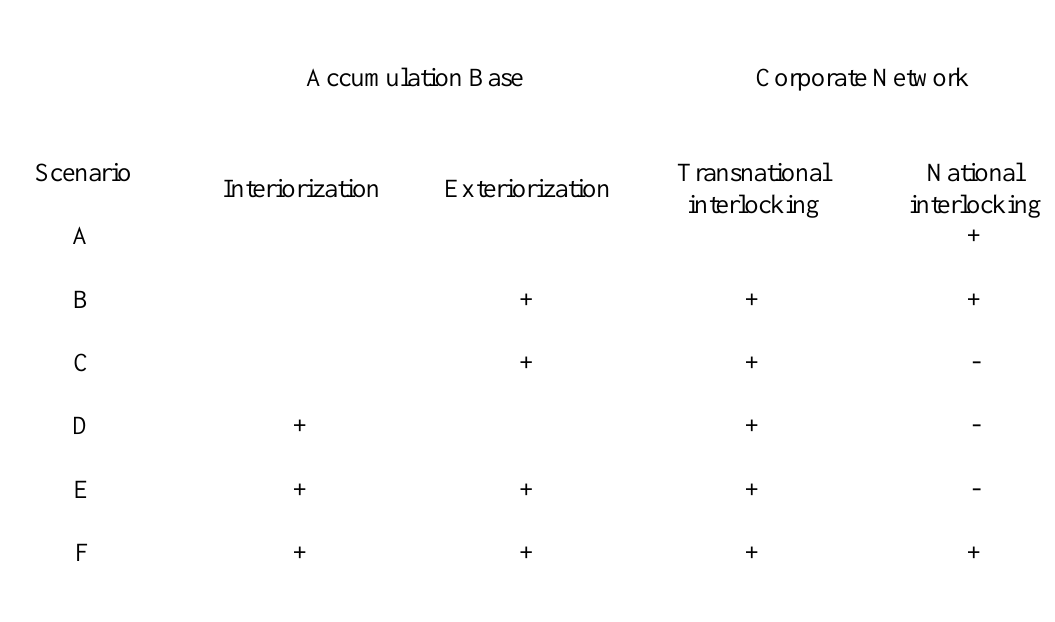
Table 1. Scenarios of Transnationalization for National Corporate